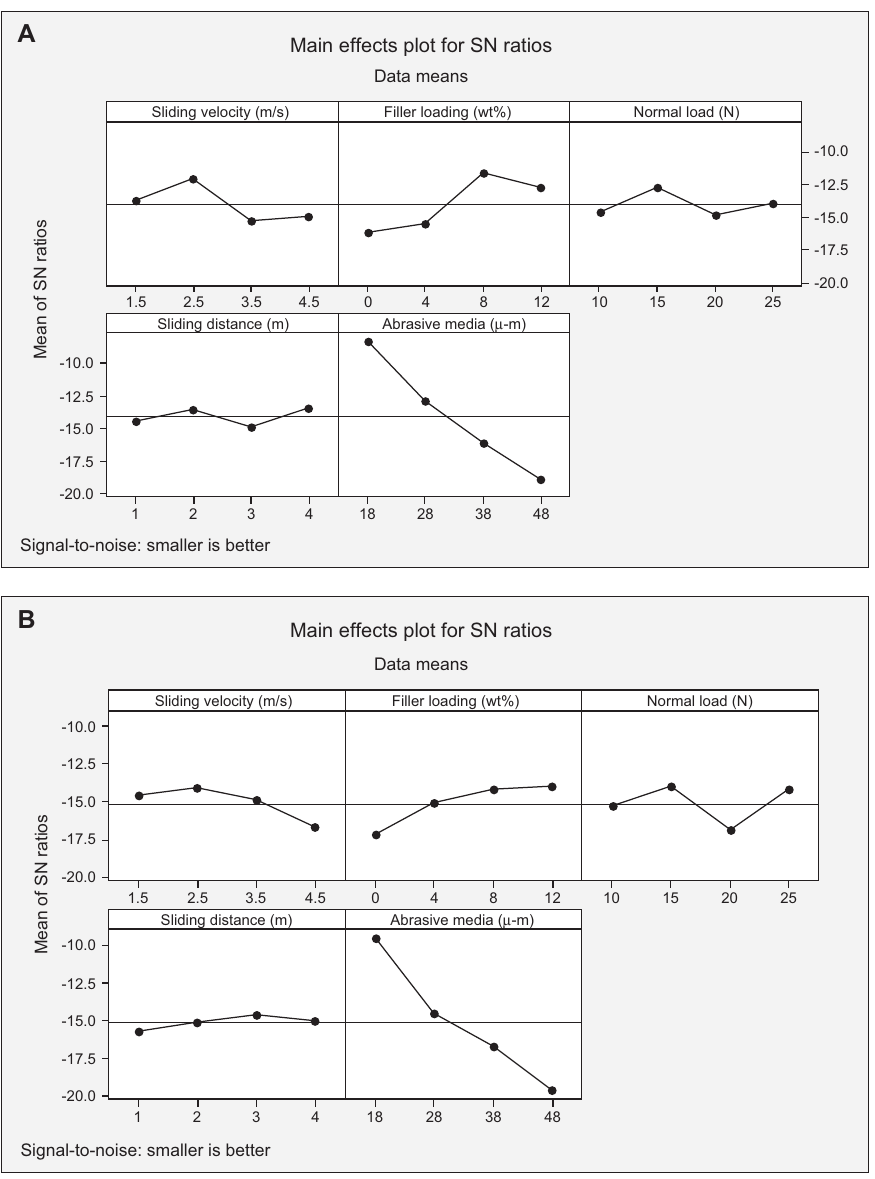
Figure 7 (A) Effect of control factors on specific wear rate of graded composites. (B) Effect of control factors on specific wear rate of homogeneous